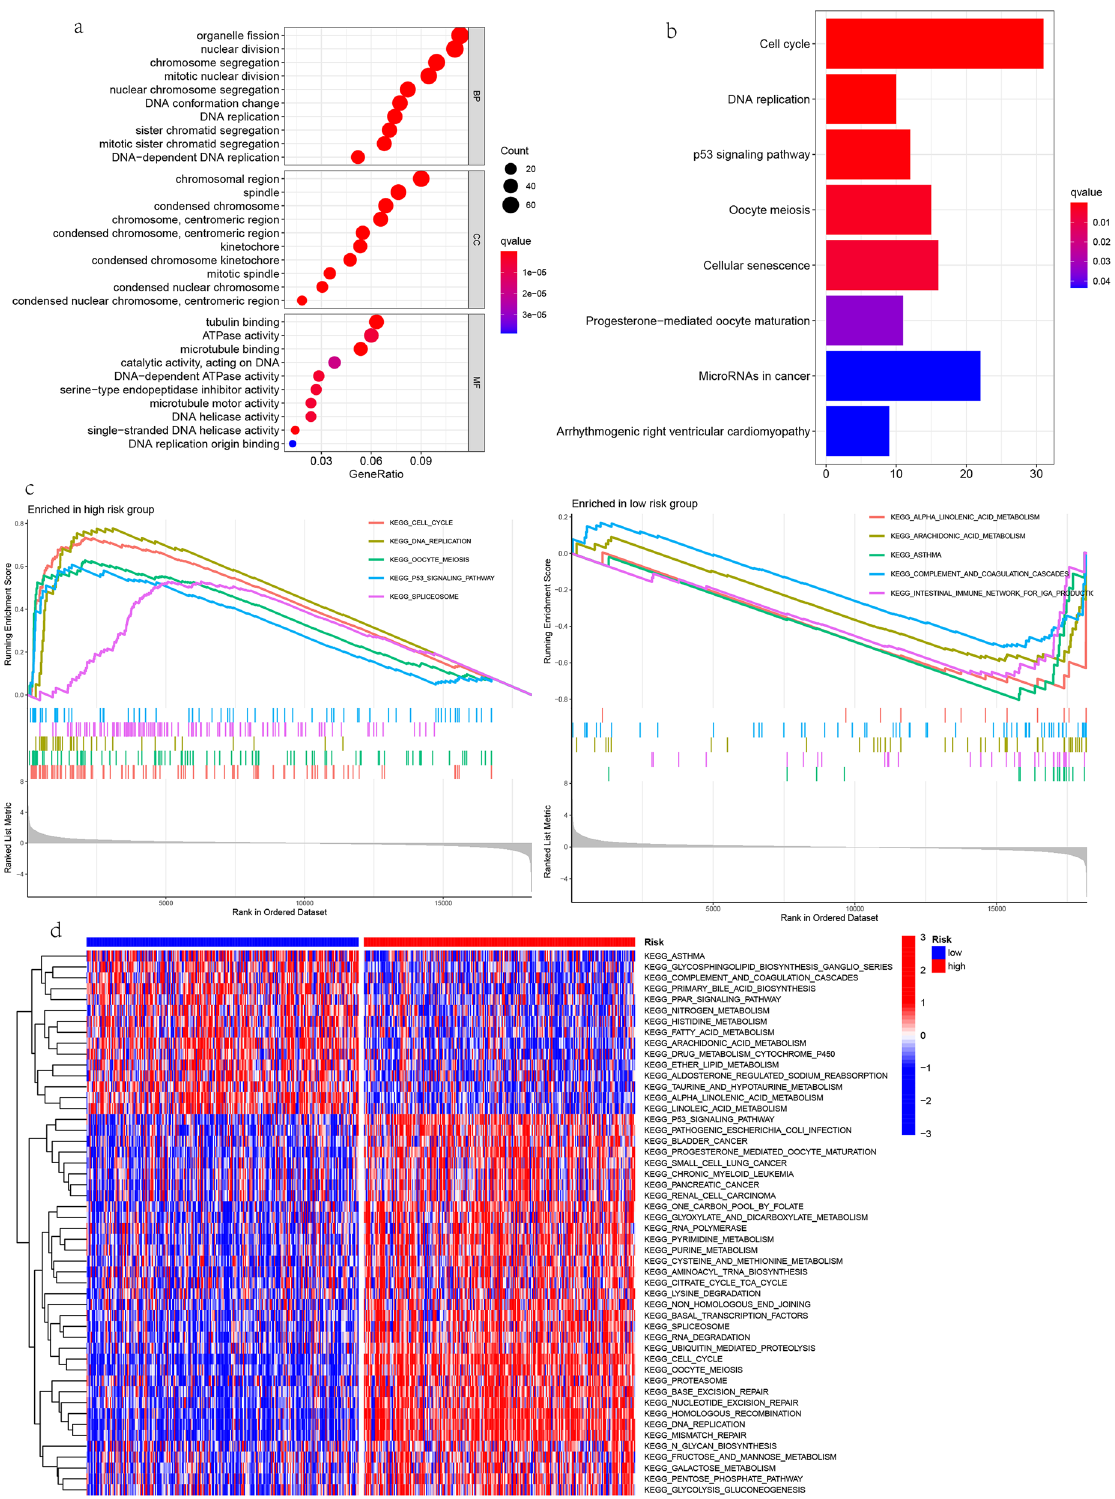
Figure 8. Enrichment analysis. ( a ) The bubble chart shows the Gene ontology (GO) analysis of differential genes between high-risk and low-risk groups based on The Cancer Genome Atlas (TCGA) database. ( b ) The histogram shows Kyoto Encyclopedia of Genes and Genomes (KEGG) analysis of differential genes between high-risk and low-risk groups based on TCGA database. ( c ) Gene Set Enrichment Analysis (GSEA) of differential genes between high-risk and low-risk populations based on TCGA database. The five main up-regulated pathways in the high-risk group (left) and the five main up-regulated pathways in the low-risk group (right). ( d ) Gene Set Variation Analysis (GSVA) of pathway enrichment between high and low risk